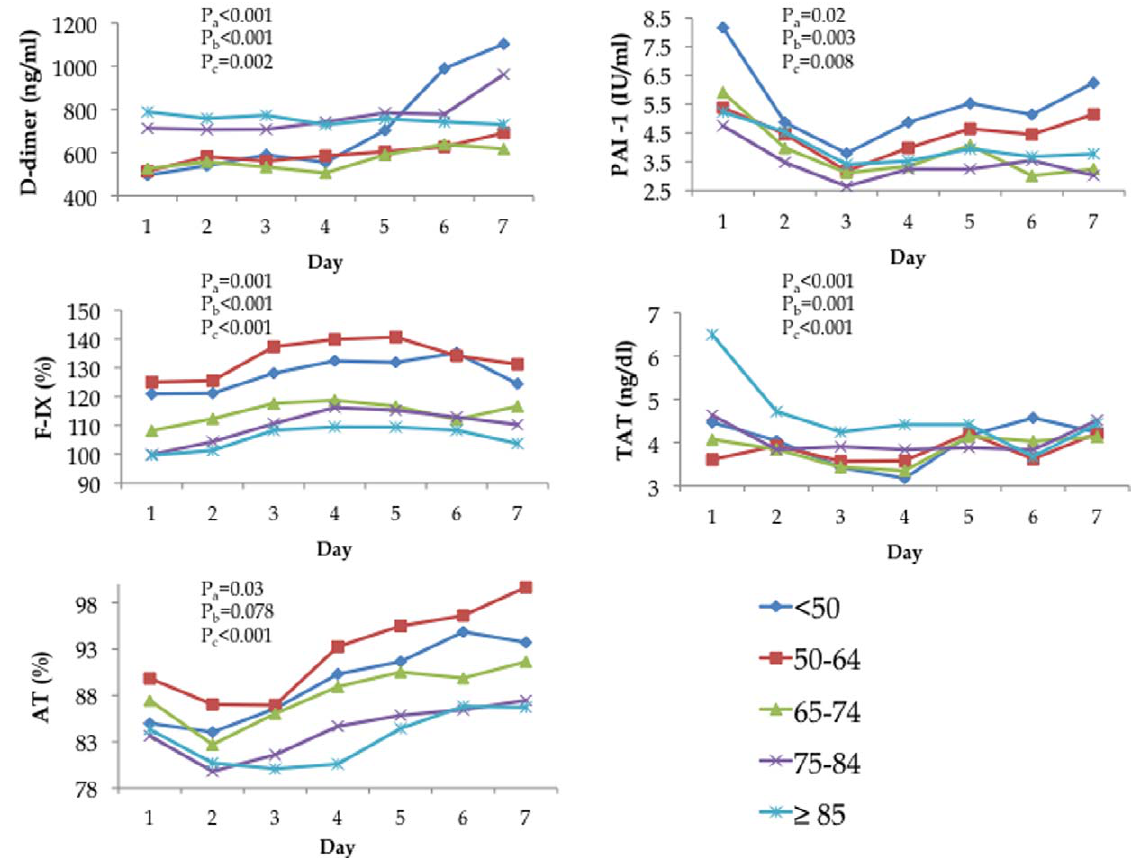
Figure 1. A modest pro-coagulant response was seen in older subjects upon ED admission (Day 1) and during the first week of hospitalization. There was an age-related increase in mean values of hemostasis markers D-dimer and thrombin-antithrombin complex (TAT) and an age-related decrease in F-IX, plasminogen-activator inhibitor-1 (PAI-1), and antithrombin (AT). Pa are p values from ANOVA or Tobit models adjusted for sex, race, comorbidity, and smoking status to compare differences in mean levels of markers on Day 1 across different age groups. Pb are p values for linear trend tests for markers on Day 1, adjusted for sex, race, comorbidity, and smoking status. Pc are p values from mixed effects model adjusted for sex, race, comorbidity, and smoking status to compare mean levels over the first week.